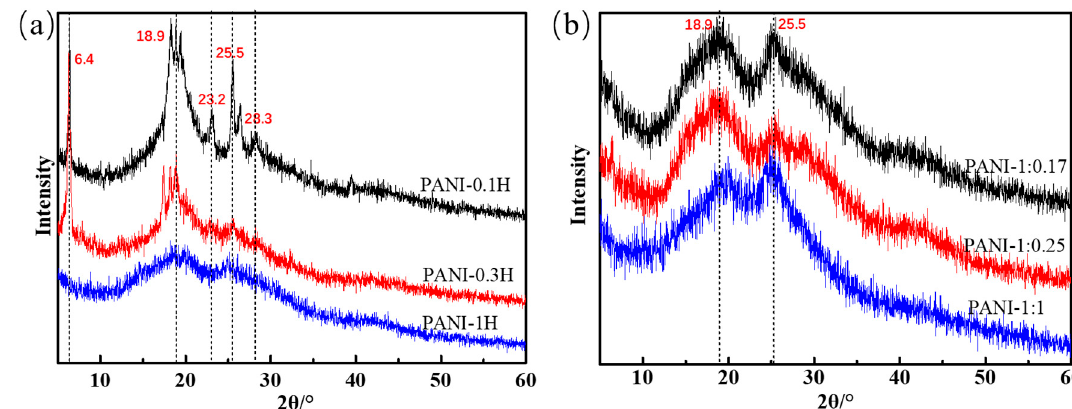
Figure 4. XRD patterns of PANIs synthesized at di ff erent reaction conditions. ( a ) Di ff erent HCl concentrations; and ( b ) Di ff erent molar ratio of aniline / APS.